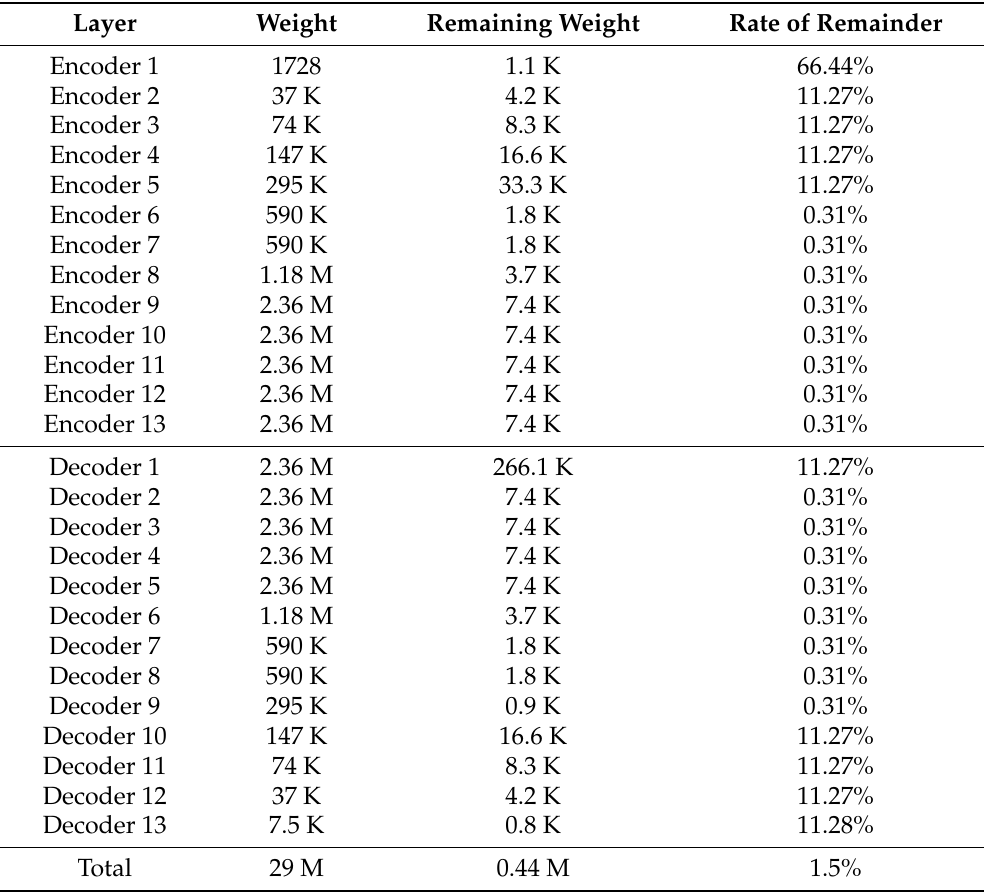
Table 5. Remaining weights and compression rate for each layer in